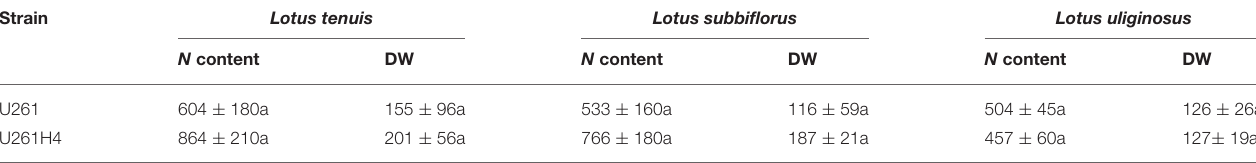
TABLE 4 | Effect of the introduction of hup genes on symbiotic performance of M. loti U261 strain in association with the indicated host legumes. Strain Lotus tenuis Lotus